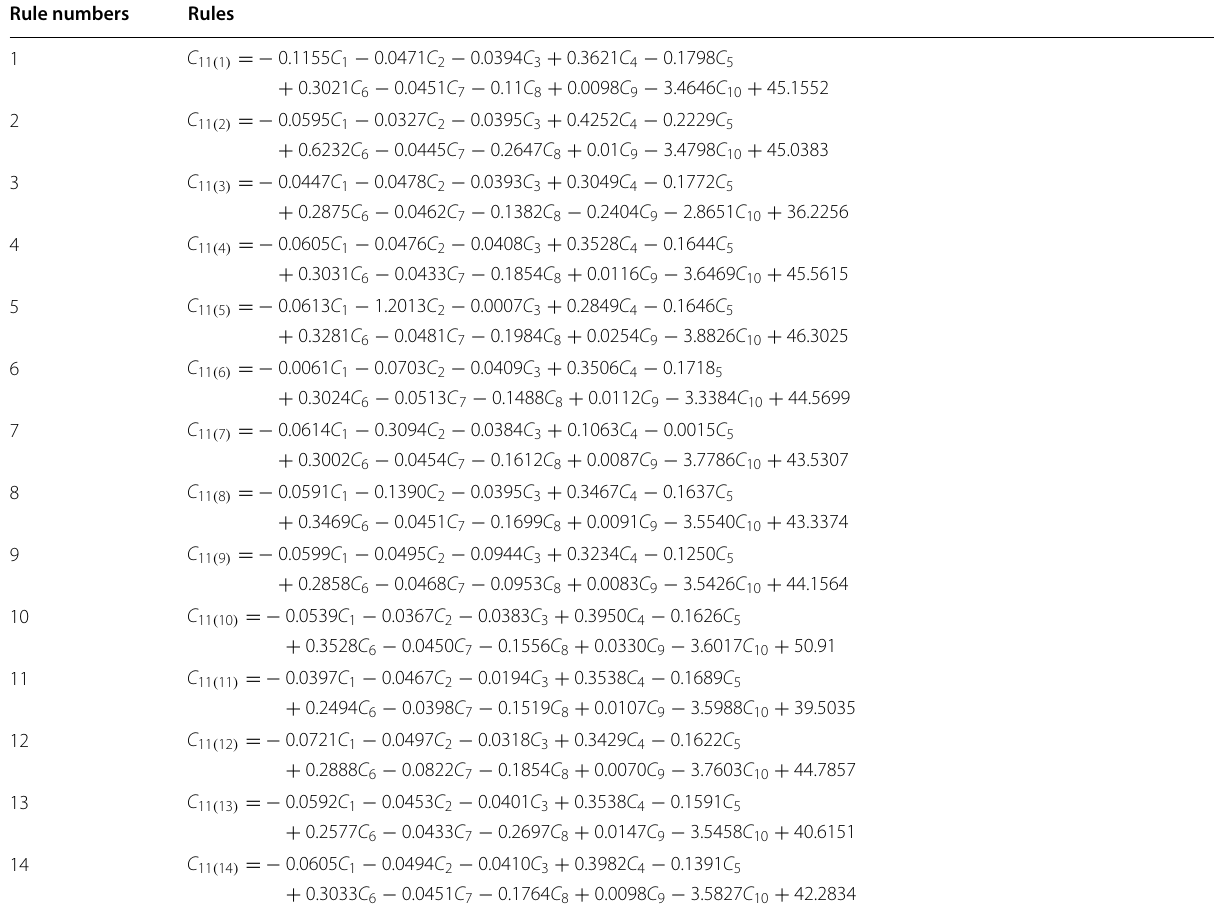
Table 8 The optimal consequent parameters after